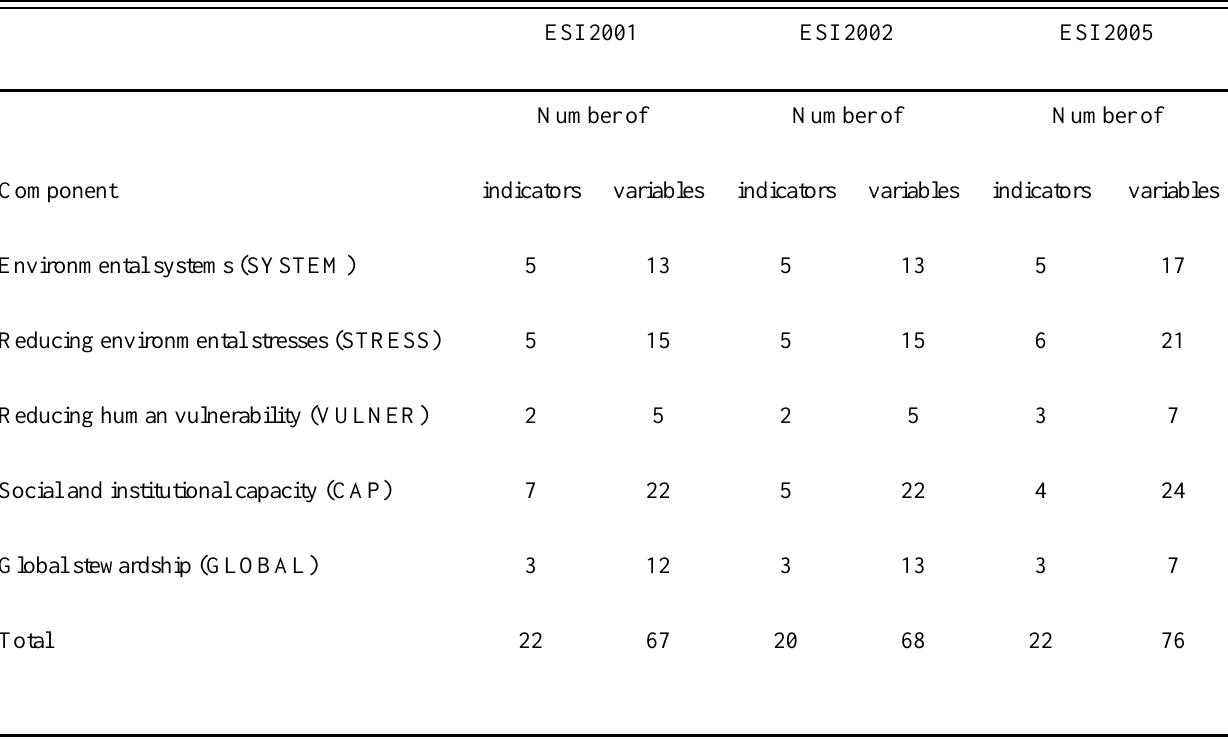
Table 1. The number of indicators and variables comprising the Environmental Sustainability Index (ESI) in 2001, 2002, and 2005.